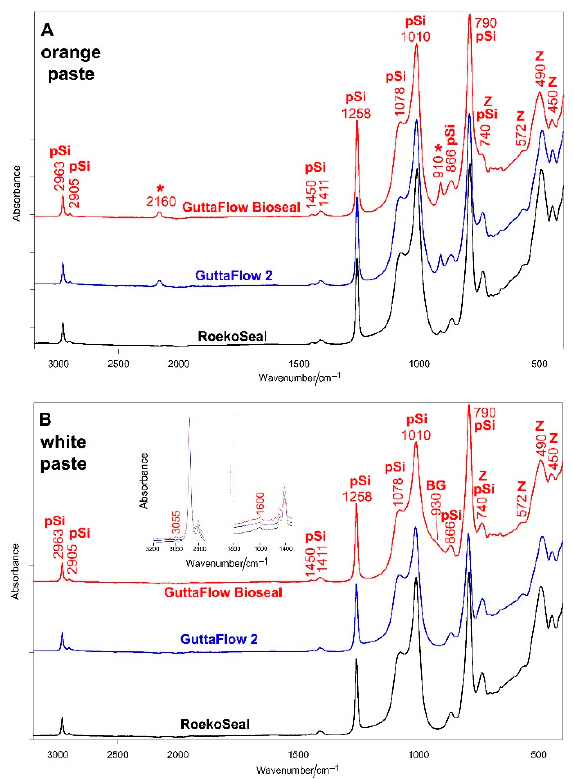
Figure 1. The average IR spectra of orange ( A ) and white ( B ) pastes of RoekoSeal, GuttaFlow 2, and GuttaFlow Bioseal. The spectra are normalized to the absorbance of the 2963 cm − 1 band. The bands assignable to polydimethylsiloxane (pSi), monoclinic zirconia (Z), and bioactive glass ‐ ceramic (BG) are indicated together with those specifically assigned to Si ‐ H bonds (*). The insets show the spectral ranges where the modes ascribable to vinyl groups are reported to fall (i.e., C=C stretching at about 1600 cm − 1 and =CH stretching at about 3055 cm − 1 ). More detailed assignments are summarized in Table S1, Supplementary Material.